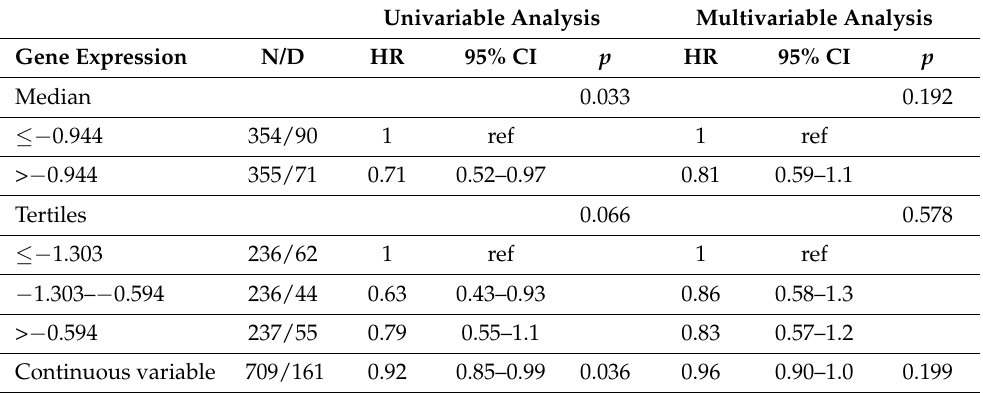
Table 19. Overall Survival of 709 NB patients in relation to NTSR2 expression levels evaluated by the Cox regression model.